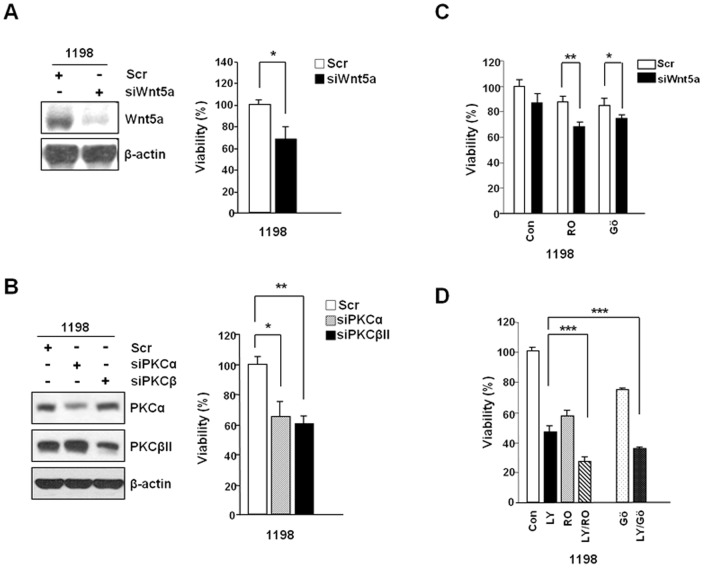
Inhibition of Wnt5a-mediated signaling in pre-malignant HBE cells.(A) 1198 cells were transfected with scrambled siRNA (Scr) and siWnt5a for 48 h. Cell viability was performed by cell counting. (B) 1198 cells were transfected with scrambled siRNA (Scr), siPKCα and siPKCβII for 48 h. Cell viability was performed by cell counting. (C) siRNA transfected 1198 cells were treated with PKC inhibitors (RO: 2.5 µM Ro-318226 and Gö: 2.5 µM Gö6o76) for 24 h and then were counted under a microscope. (D) 1198 cells were treated with PKC inhibitors alone and combination with PI3K inhibitor (LY: 10 µM LY294002).